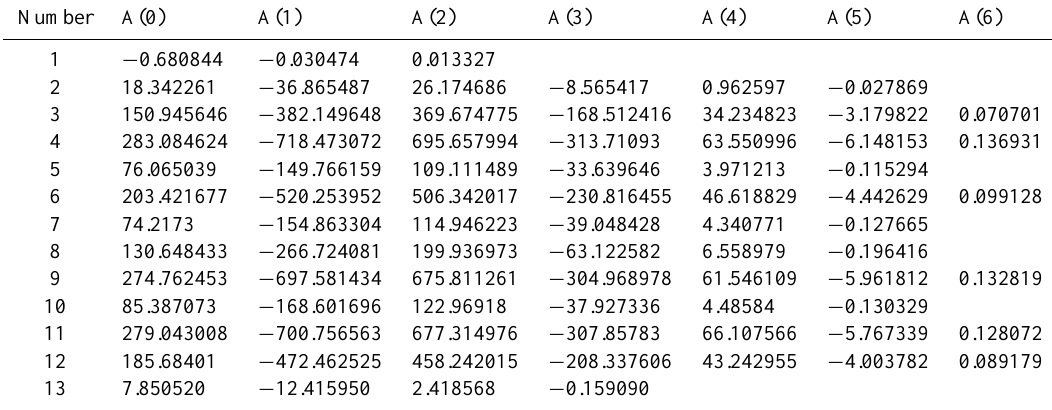
= A ( 0 ) ∗ x order w i